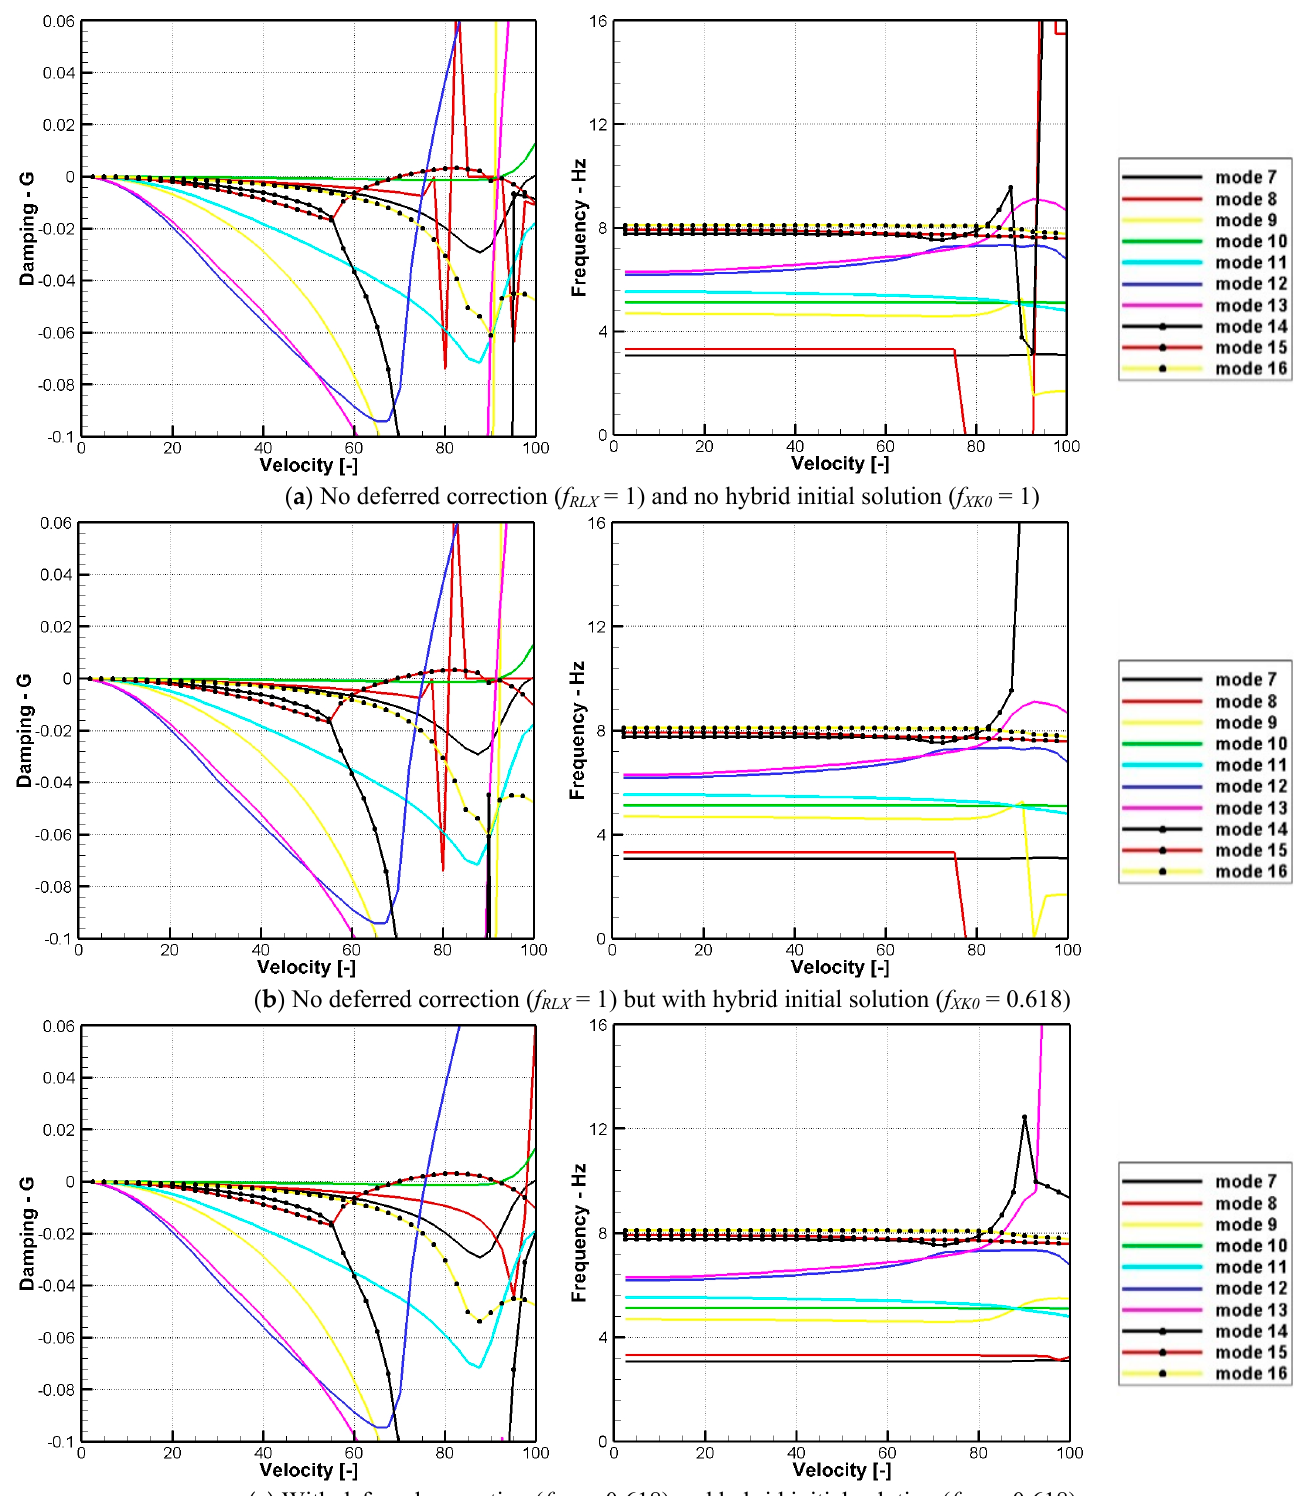
Figure 10. Effects of deferred correction scheme for the FLUTQ PK-method: damping and frequency diagrams of the Symmetric 2 configuration of a real-world jet aircraft with velocities arbitrarily normalized.